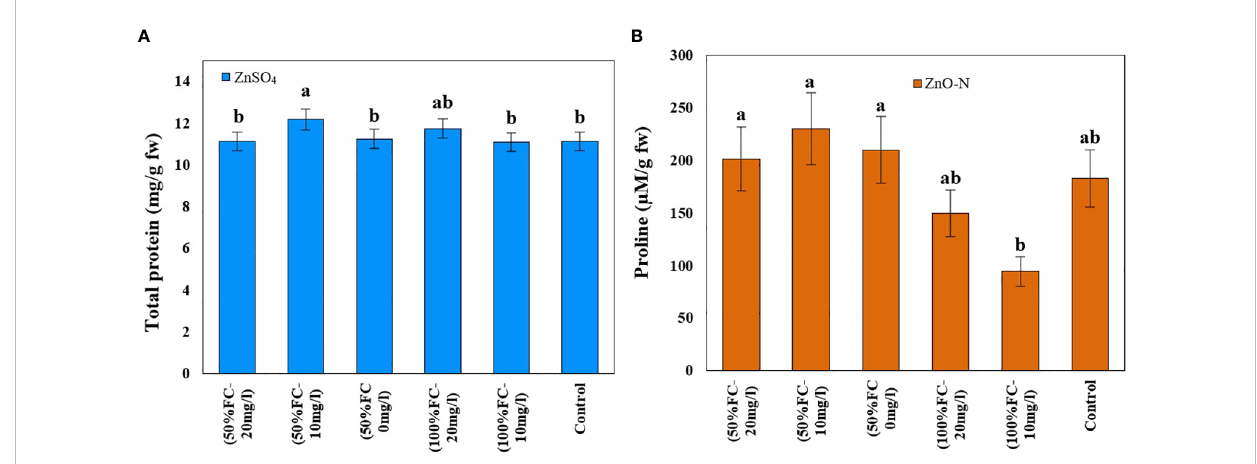
FIGURE 4 Impact of ZnSO 4 on total protein (A) and ZnO-N on proline (B) and in D Kotschyi under Drought Stress. Means followed by the same letters did not differ signi fi cantly at p ≤ 0.05, n = 4.